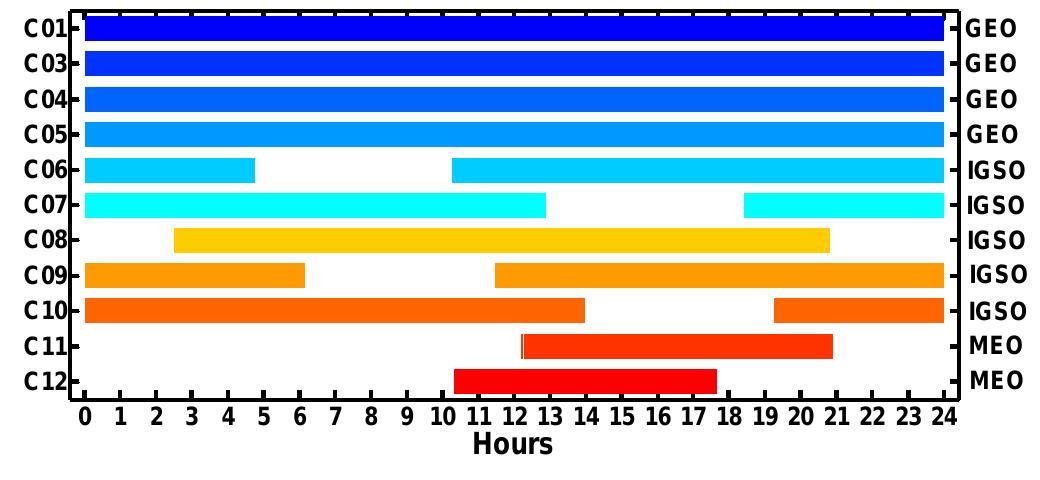
Figure 2. Visibility of BeiDou satellites at CHDU on September 24, 2012 (the mask elevation is